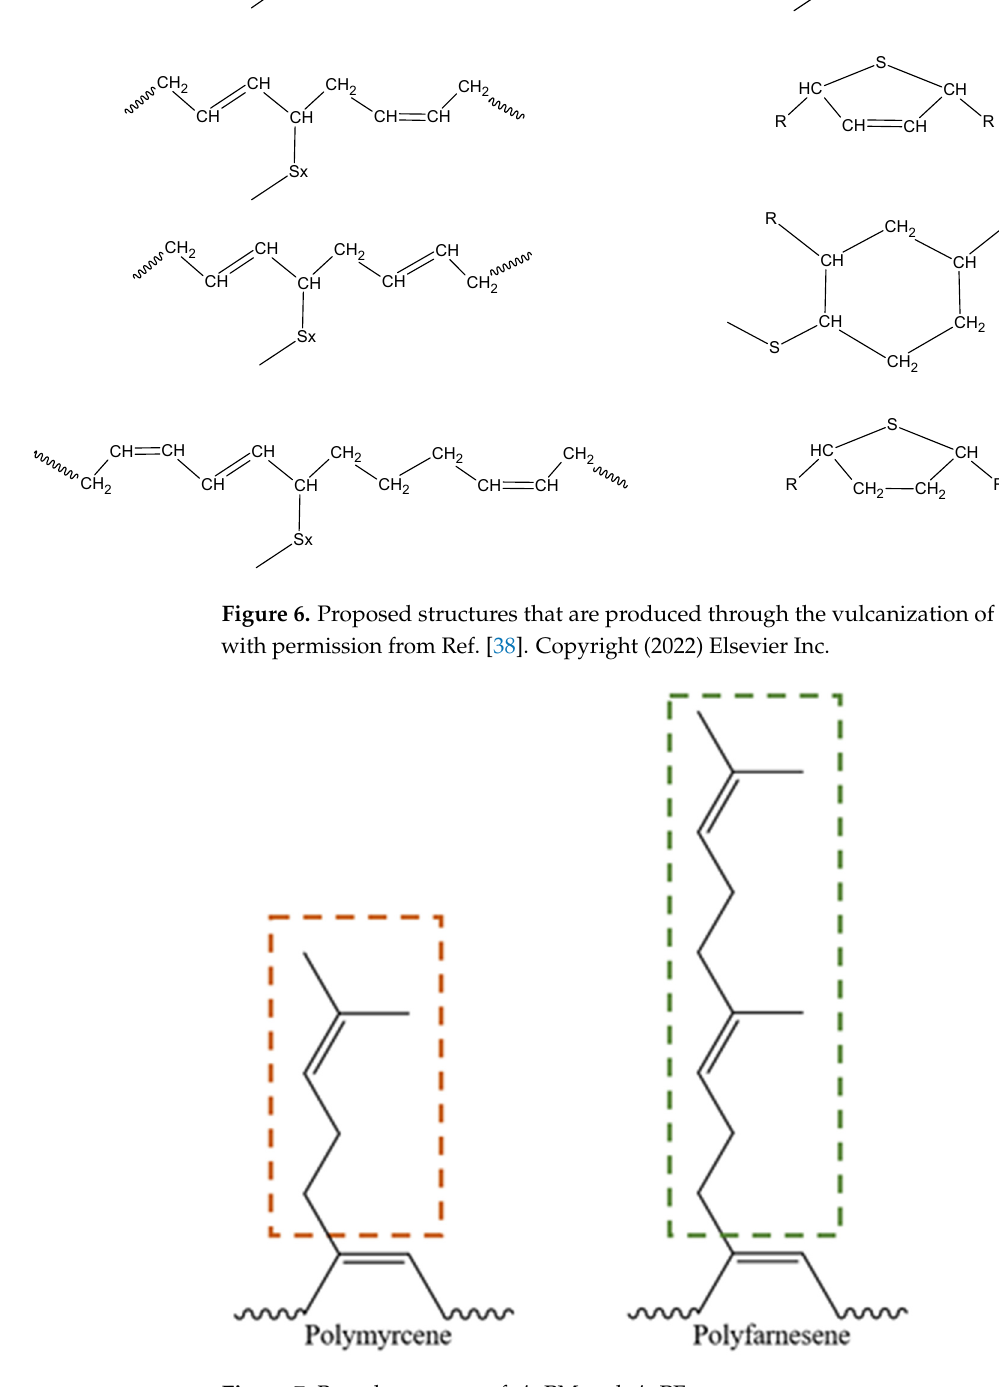
Figure 7. Branch structure of cis -PM and cis -PF.